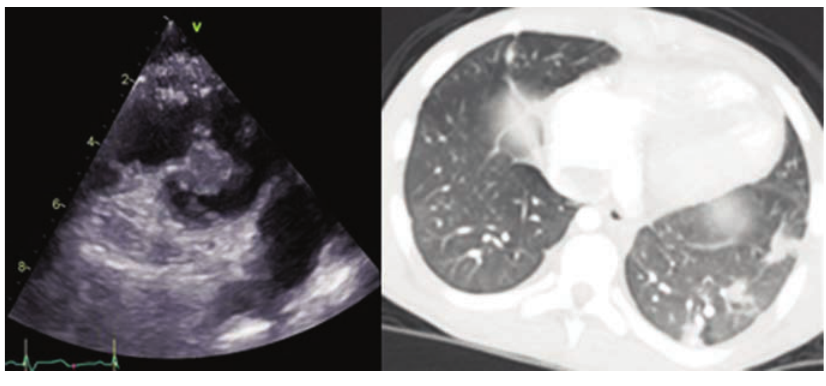
Figure 1. Transthoracic echocardiogram demonstrating the largest mobile mass on pul- monary valve (20 × 12 mm) and companion chest computed tomography showing sub- sequent pulmonary